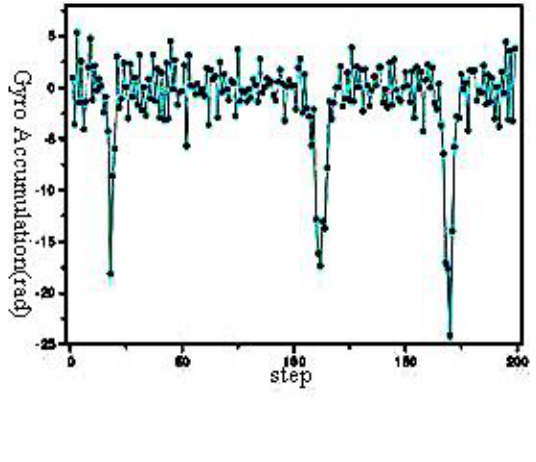
Figure 6 Accumulated gyroscope data.